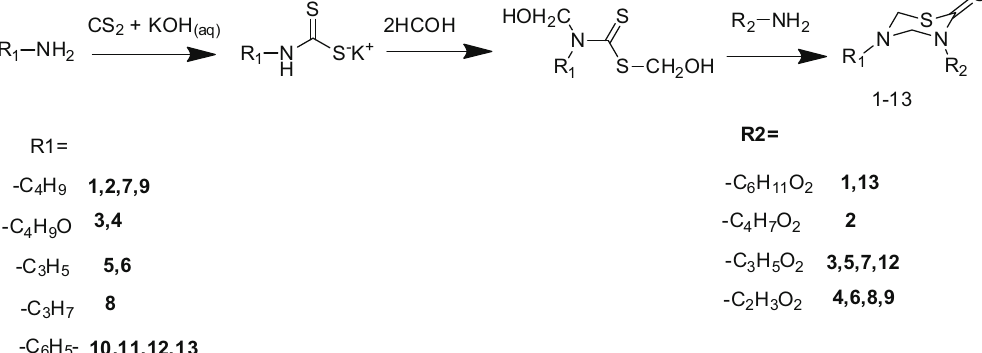
Scheme 1: General scheme for the synthesis of the title